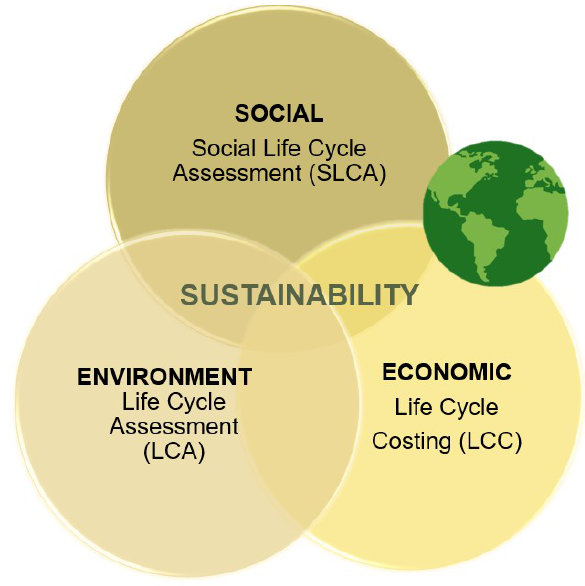
Figure 9. For the development of advanced composite CF-based materials for high value and high-performance applications, the assessment of environmental, social, and economic aspects is deemed necessary, in order to ensure their benefits from a sustainability perspective.